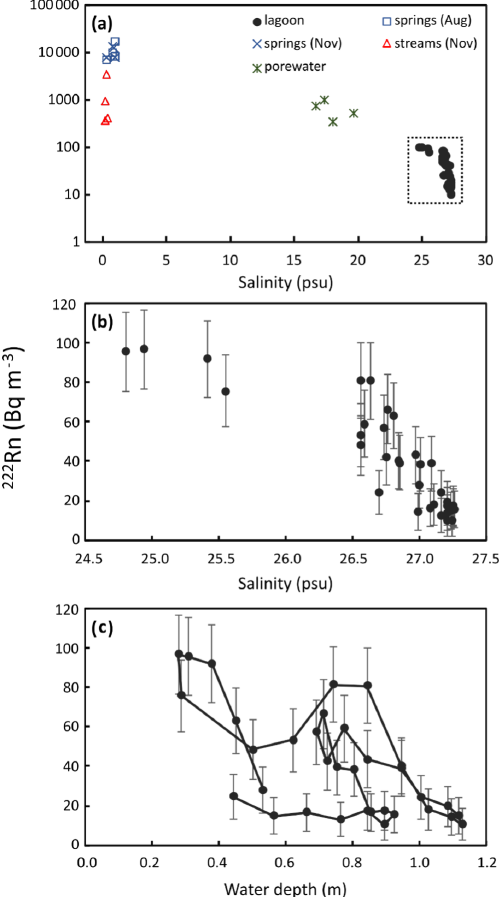
Figure 8. 222 Rn variability versus salinity (a, b) and tidal water level (c) , including hysteresis loops over two August 2020 tidal cy- cles; panel (b) depicts the lagoon data points outlined in (a) at a greater resolution. 222 Rn values are listed in Table